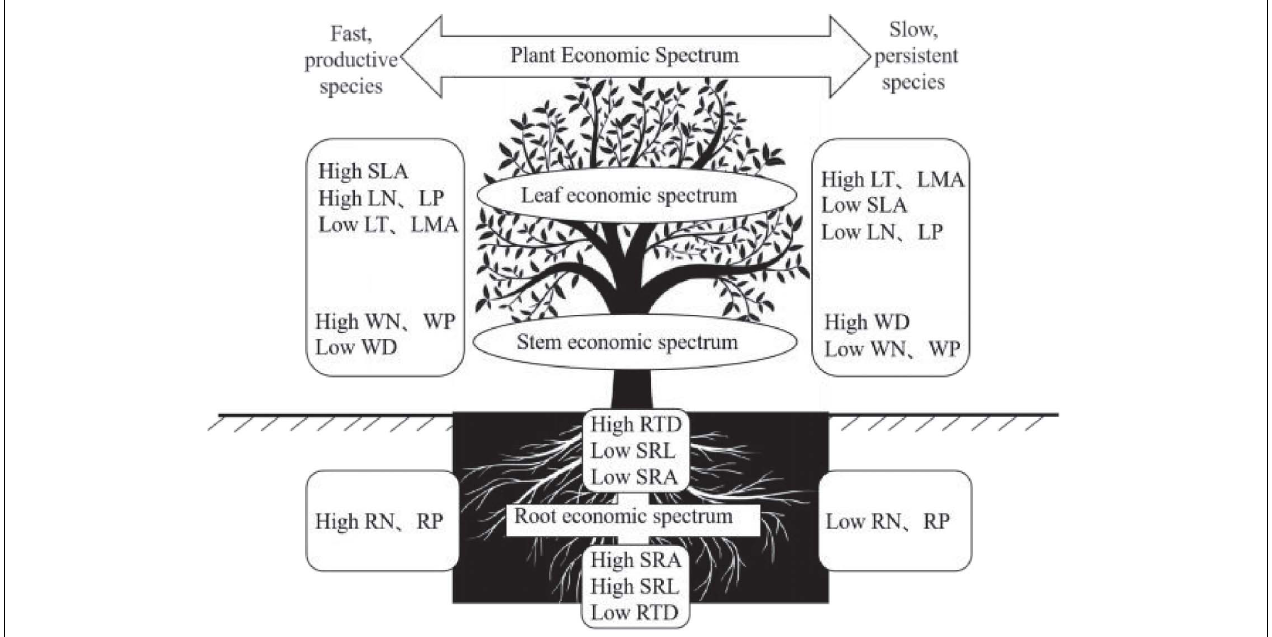
FIGURE 4 | Conceptual illustration of the plant economic spectrum (PES). The nutrient traits of fine roots, such as RN and RP, are consistent with the leaf economic spectrum (LES), while the morphological traits of fine roots, such as RTD, SRL, and SRA, are independent of the PES.